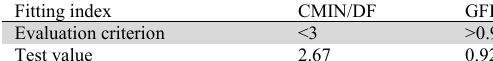
Fit indices of the structural